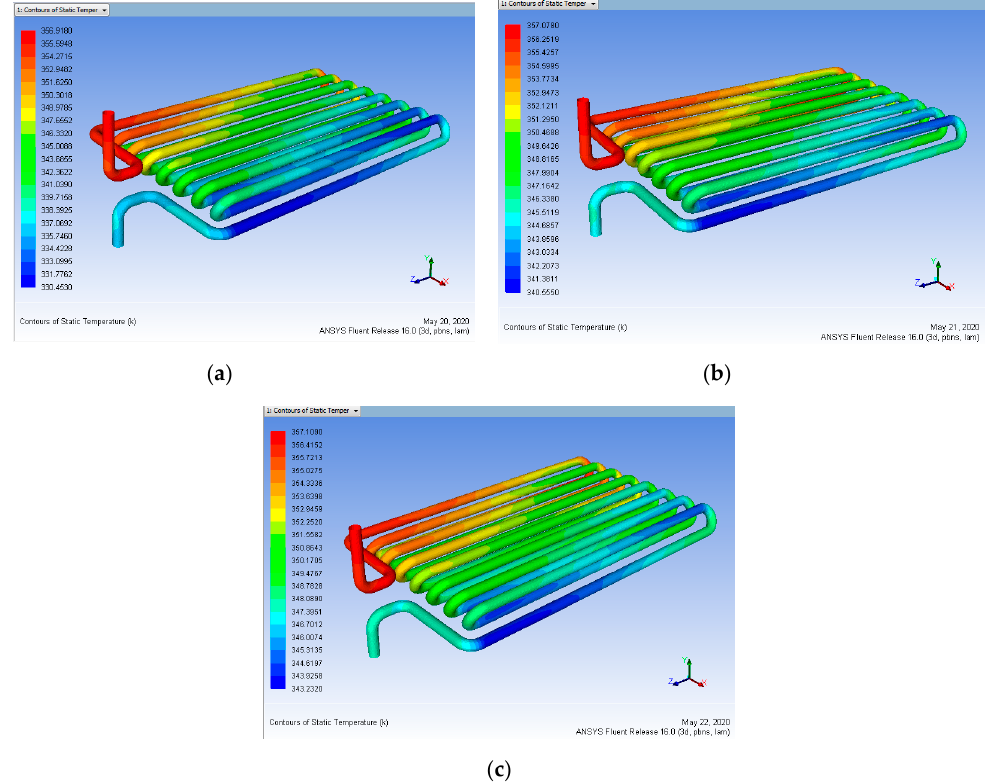
Figure 24. Heat input 363 K vs. Coating Thickness 100 µm for mass flow rate ( a ) 0.15, ( b ) 0.30, ( c ) 0.45 L/min (After Coating). Table 13. CFD Analysis Reading for 363 K.